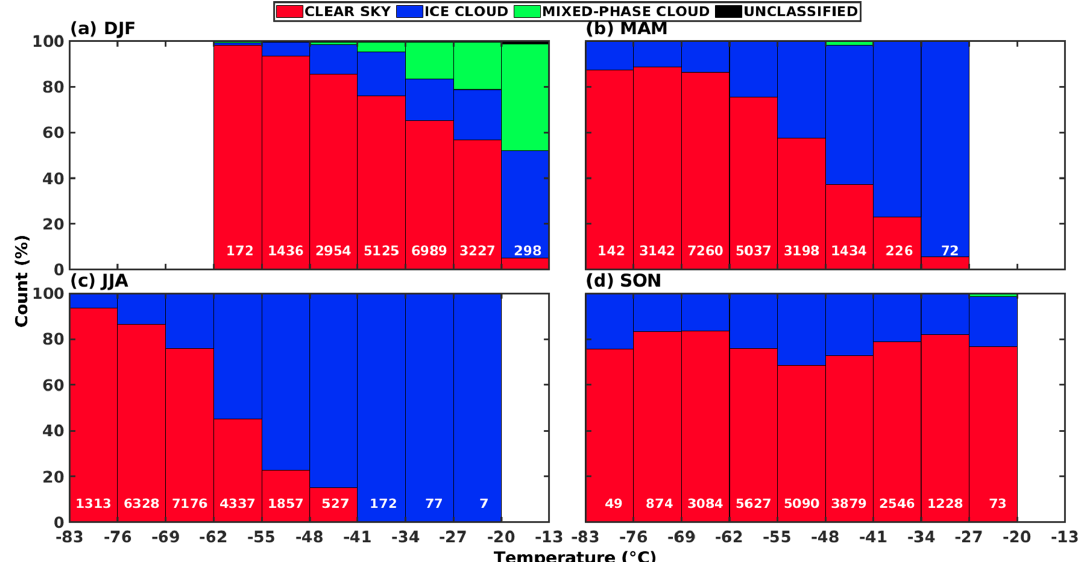
Figure 8. Histograms of the seasonal occurrence of the analyzed sky conditions as a function of the surface air temperature. (a) DJF – summer, (b) MAM – autumn, (c) JJA – winter, and (d) SON – spring. The number of observations for each 7 ◦ C bin is reported at the base of each